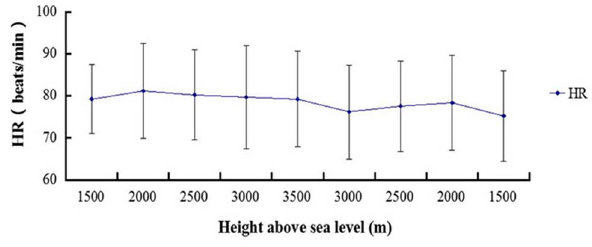
Figure 2. Graph showing the HR during the ascent and descent phases. The change in HR during the ascent and descent phases had no significant relationship with altitude changes (P . 0.05).